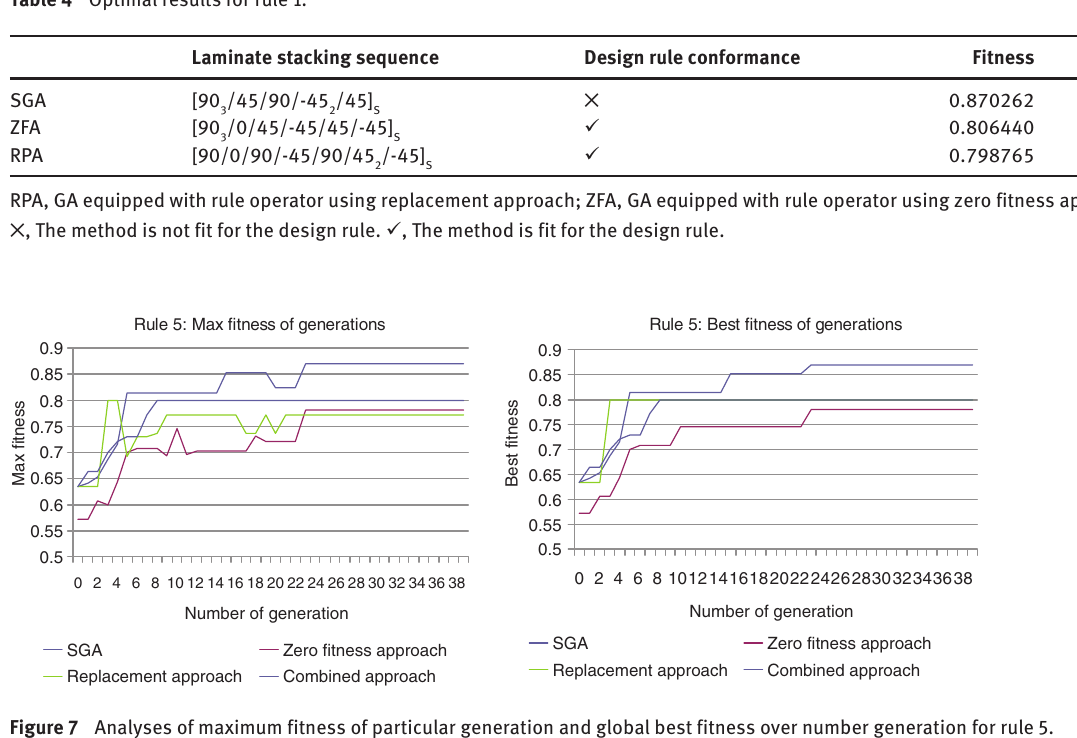
Figure 7 Analyses of maximum fitness of particular generation and global best fitness over number generation for rule 5.